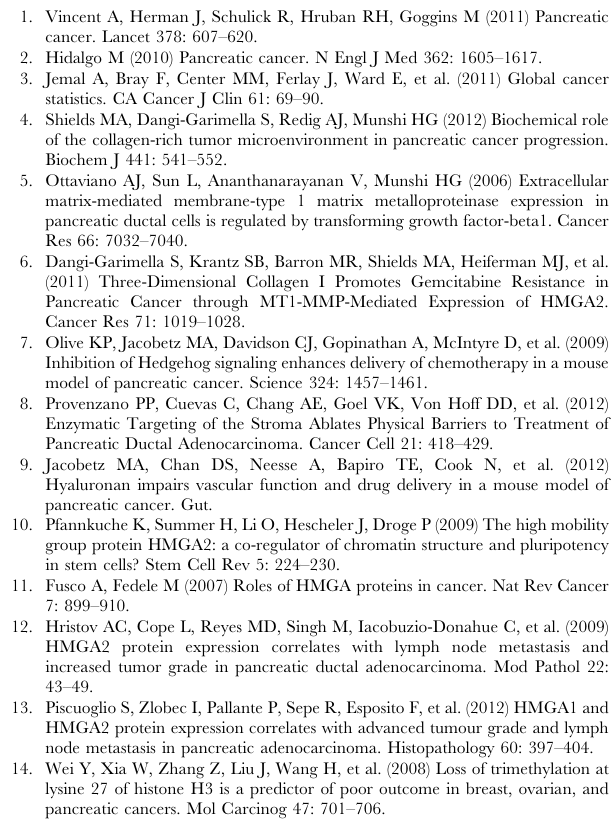
Figure S1 Effect of 2D collagen on histone H3K9 and histone H3K27 acetylation. A, B . Panc1 and CD18 cells were grown on tissue culture plastic or on collagen I-coated tissue culture plates (BD BIocoat Collagen I) for 24 hours. Cells were lysed and immunoblotted for histone H3K9Ac and H3K27Ac using a -tubulin as loading control. The results are representative of three independent